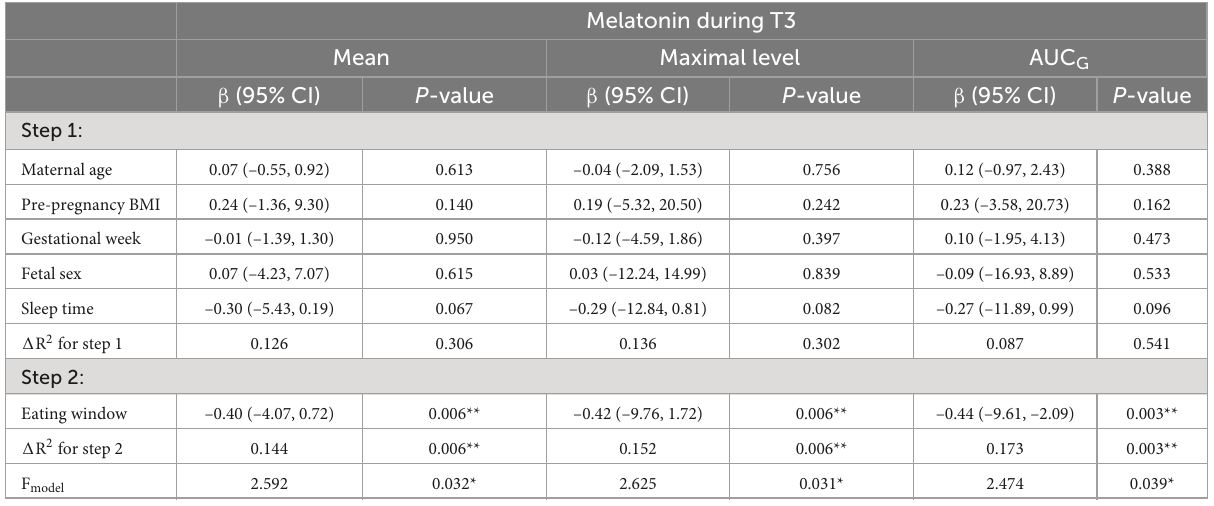
TABLE 3 Hierarchical linear regression models predicting maternal melatonin parameters from chrononutrition characteristics (T2: n = 64; T3: n = 60).